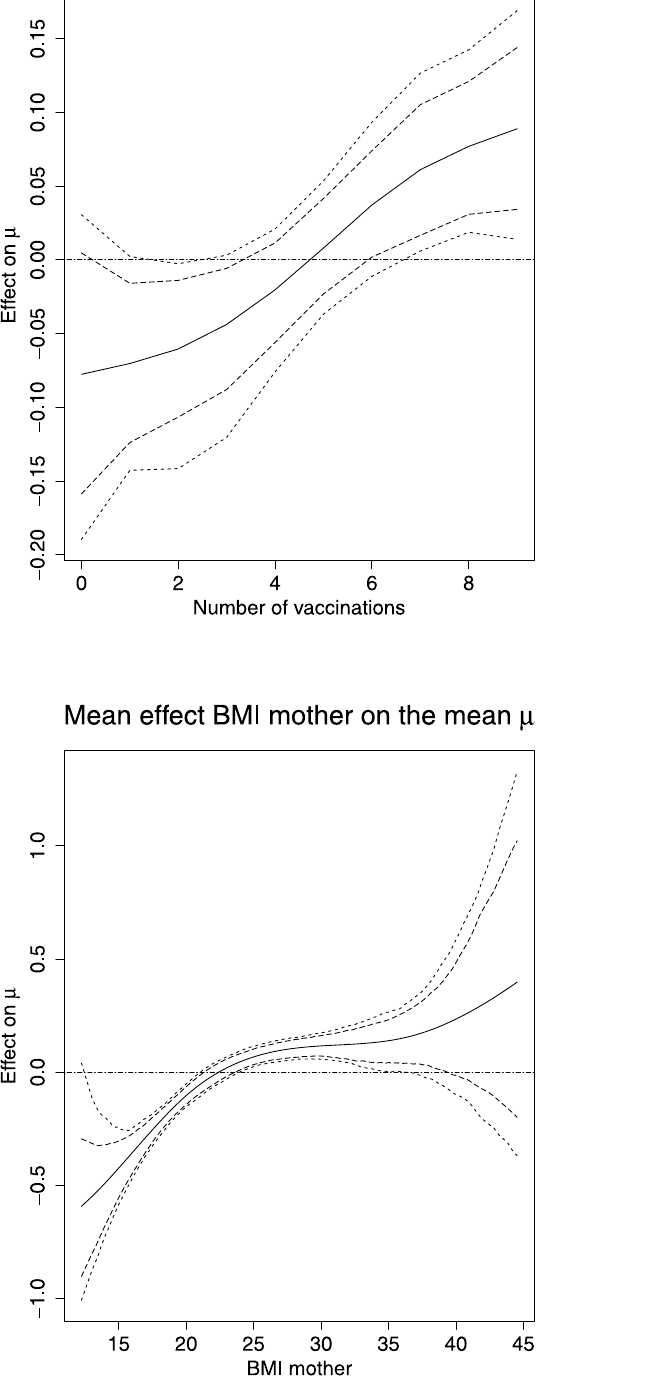
Fig 4. Non-linear effects of the vaccination coverage and the BMI of the mother. The Figure depicts the mean effects on the mean μ (left), and the standard deviation σ (right) together with 80 per cent and 95 per cent simultaneous credible intervals for the vaccination coverage (top), and the BMI of the mother (bottom). Source : Demographic and Health Surveys (data); calculation by authors.